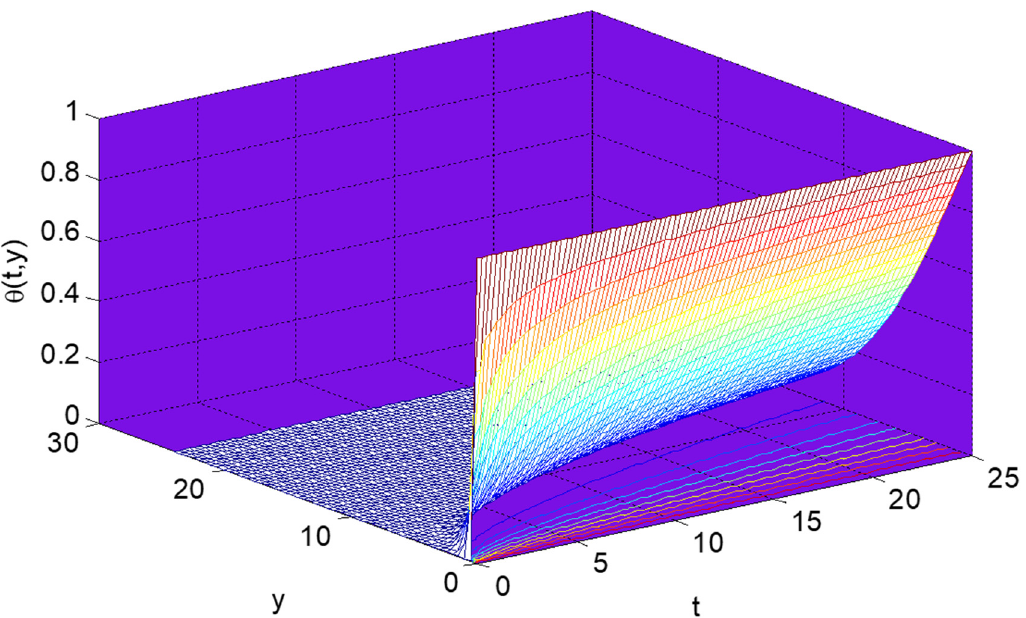
Figure 12. Surface plot with underneath contours for temperature profile of Stokes’ second problem in Quantum Calculus by the proposed scheme for spatial direction and Crank–Nicolson scheme for time direction using N y = 50, N t = 100, q = 0.8, λ = 0.01, β = 0.01, Pr = 0.9, L = 24.